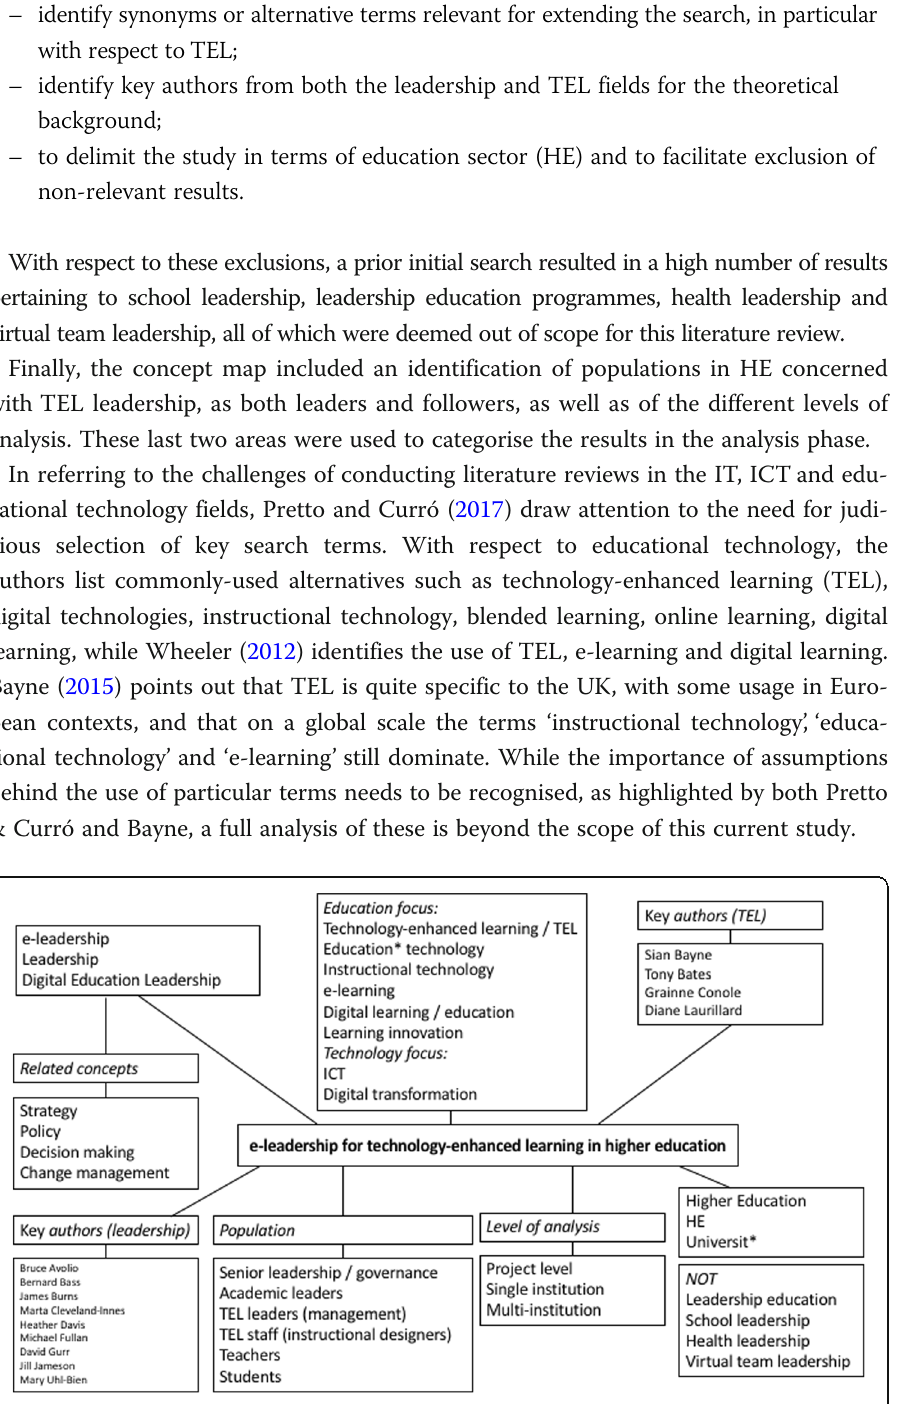
Fig. 1 Concept map for literature